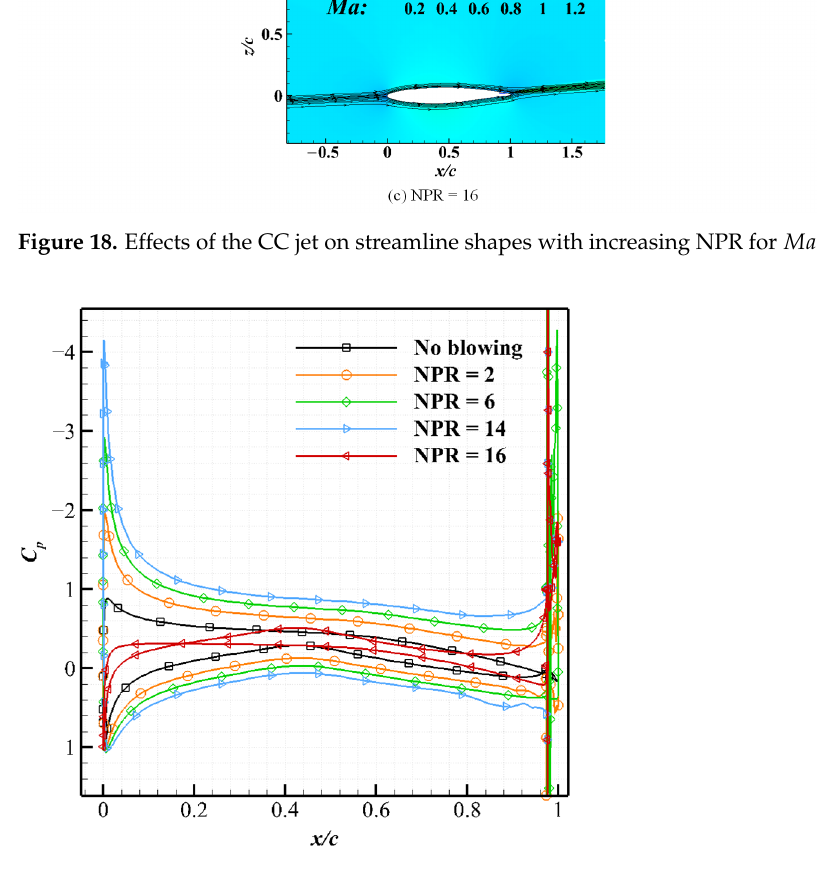
Figure 19. Comparison of pressure coefficients due to changes in NPR ( Ma =